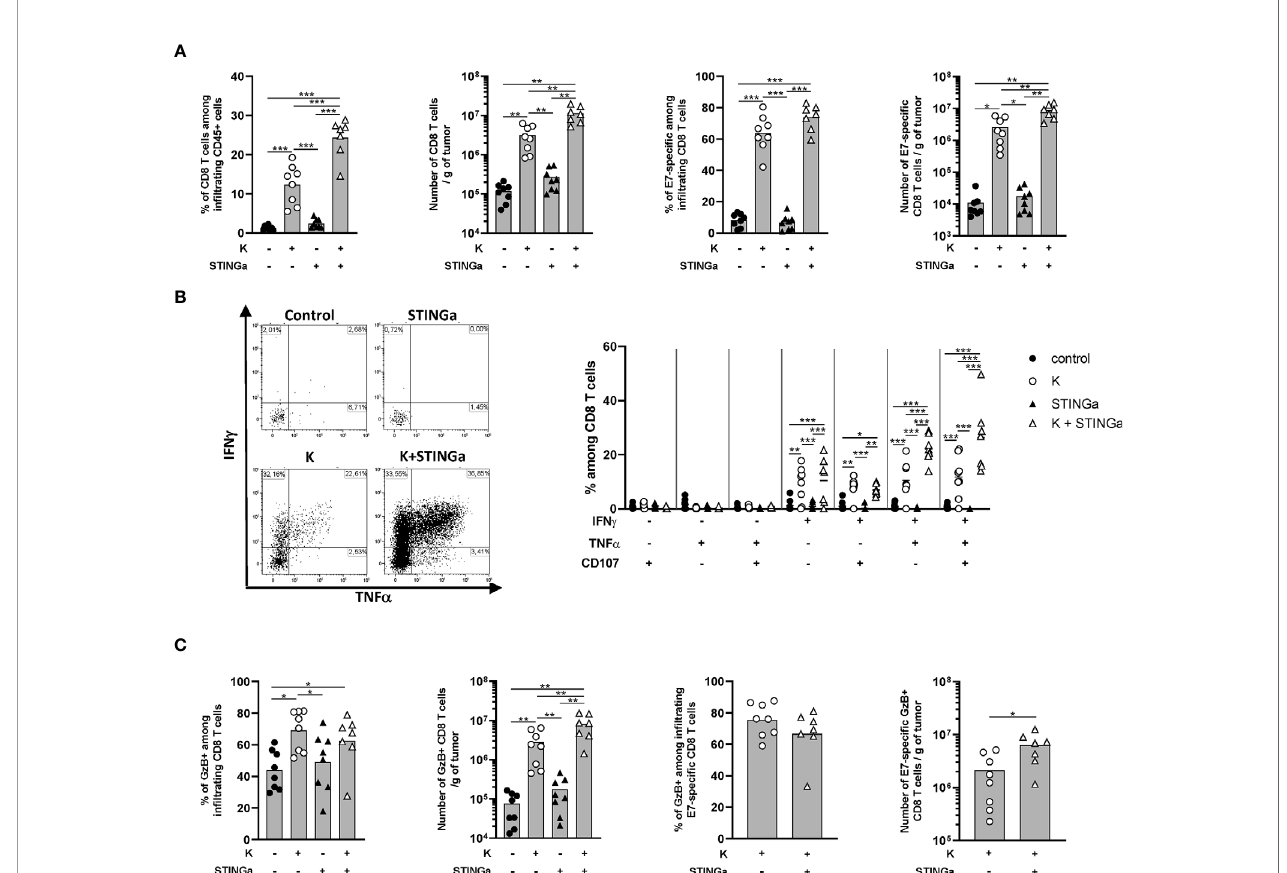
FIGURE 4 | Combining protein vaccine treatment with STING agonist enhances functionality of intra-tumoral CD8 T cells in TC-1 model. 10 5 TC-1 cells were implanted subcutaneously on the back of C57BL/6 mice. When tumors were visible, mice were treated with two administrations of KISIMA vaccine, STING agonist or a combination of the two at one-week interval. One week after the last treatment, mice were sacri fi ced, tumor harvested, and CD8 T cells ’ presence and phenotype were analyzed by fl ow cytometry. (A) Frequency and number of total and RAHYNIVTF (E7)-speci fi c CD8 T cells among tumor in fi ltrating leukocytes. (B) Tumor in fi ltrating CD45+ cells were stimulated ex vivo with RAHYNIVTF peptide in the presence of Golgi inhibitor. Antigen-speci fi c cytokine production was measured by intracellular staining; representative FACS plots and frequency of cytokine-producing among CD8 T cells are shown. (C) CD45+ tumor in fi ltrating cells were cultured ex vivo with Golgi inhibitor and granzyme B production was monitored by intracellular staining. Frequency and total number of granzyme B-producing total and RAHYNIVTF-speci fi c CD8 T cells are shown. (A – C) A pool of two experiments is shown (n ≥ 7/group), Mann – Whitney test , *p < 0.05, **p < 0.01, ***p <